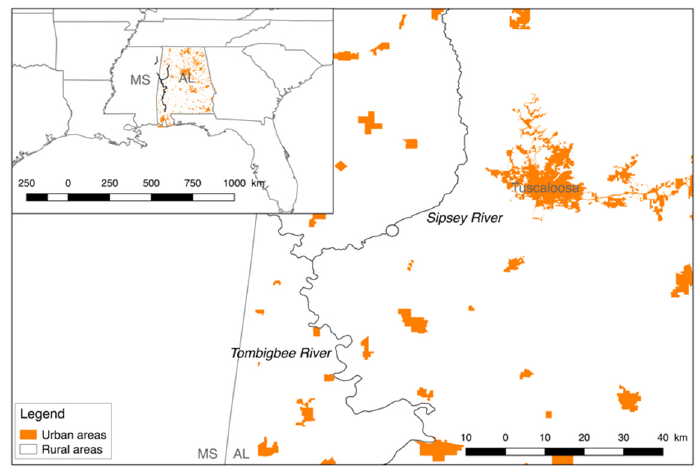
Figure 1. Six freshwater mussel species were collected between August 2016 and July 2019 from a site (circled) on the Sipsey River, Alabama, USA. The Sipsey River is surrounded by rural lands (white), with the city of Tuscaloosa representing the closest and largest urban area (orange). Temperature, pH, dissolved oxygen (mg/L), and ammonia, orthophosphate, phosphorus, nitrate, and nitrite of the water column were collected. The river flow is from north to southwest.